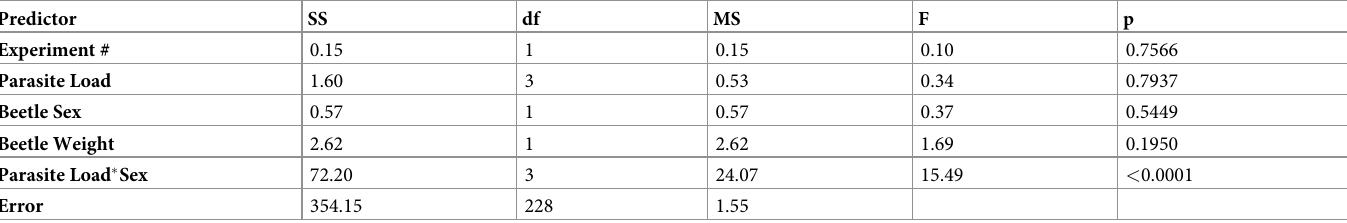
Table 2. Summary of ANCOVA model examining all potential predictors of freeze time (in seconds, log-transformed) displayed by horned passalus beetles in response to mild stressors. Parasite load refers to the 0–3 scale used to assess host burden of C . passali nematodes. The significant parasite � sex interaction is displayed in Fig 3.